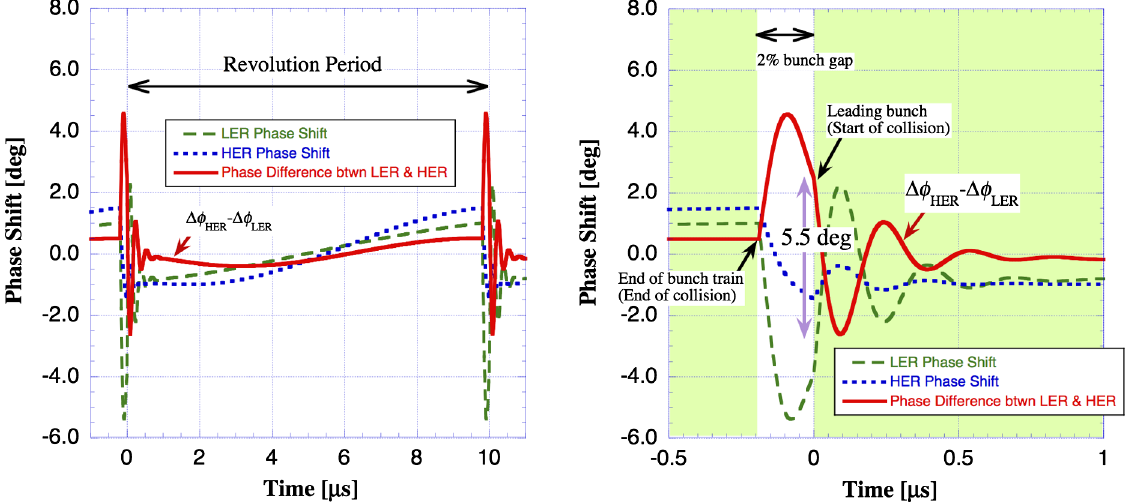
− Δ ϕ ). The right side is zoomed in around HER LER